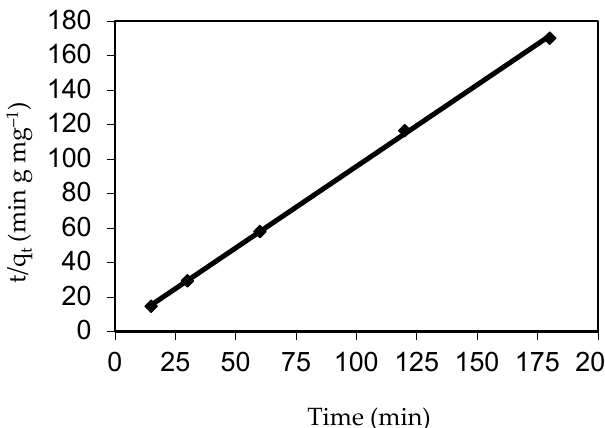
Figure 16. Adsorption kinetics of the pseudo ‐ first ‐ order kinetics of IV2R adsorption onto the ZnO ‐ NPs.